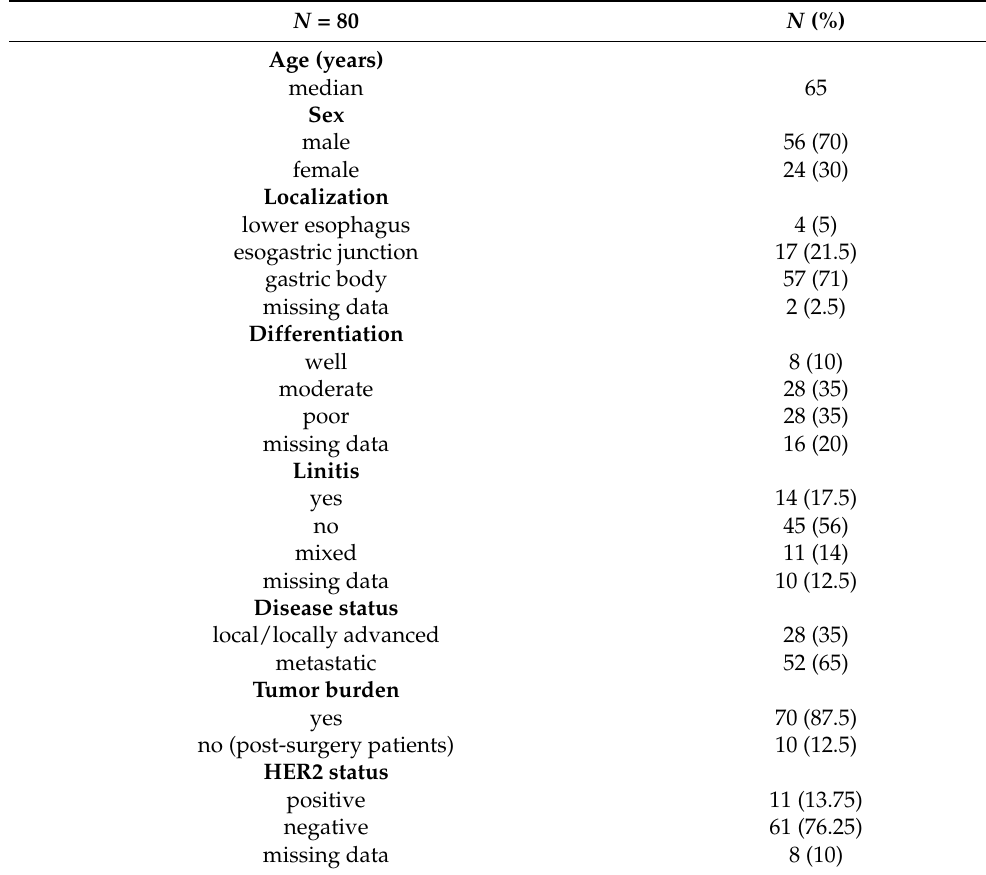
Table 1. Characteristics of patients from the HEGP